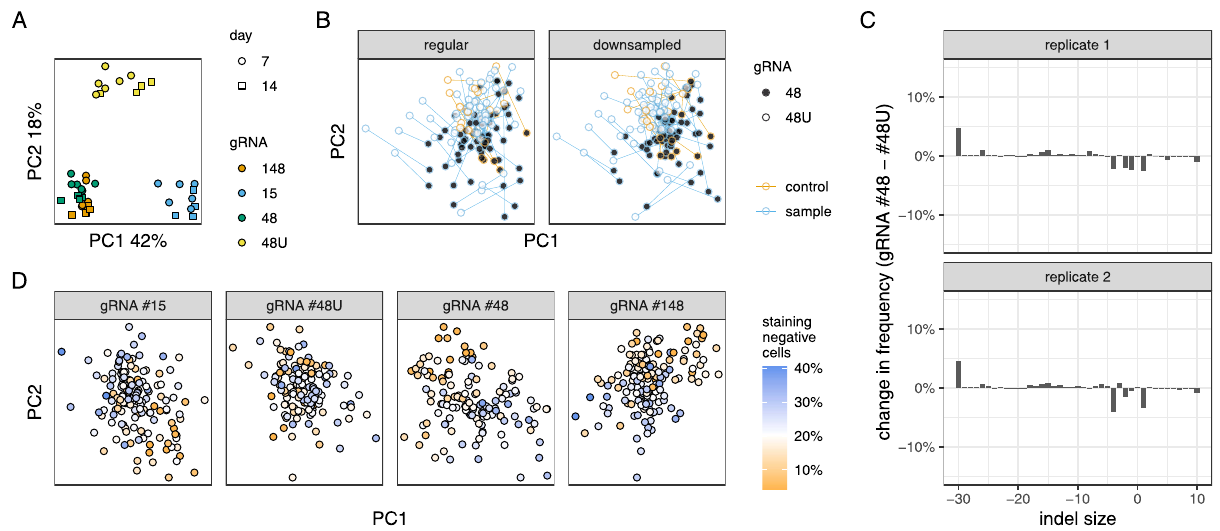
Fig. 4 Ef fi ciency of mutagenesis affects DNA repair outcomes. A Relationship between fl ow cytometry samples. gRNA #48U is a weaker version of #48. N = 4 – 6 biologically independent replicates. B Relationship between clones based on their indel pro fi les, analogous to Fig. 2B. Only non-signi fi cant clones are shown for clarity. Biological replicates ( N = 2) were averaged. C Difference in indel frequency between the regular gRNA #48 and its less active counterpart #48U. Same display conventions as in Fig. 2. D Relationship between clones based on their indel pro fi les, analogous to Fig. 2B. Each clone is colored by the frequency of mutagenesis assayed by fl ow cytometry on day 14 using gRNA #48U, a proxy for Cas9 activity. For clarity, only non-signi fi cant clones are